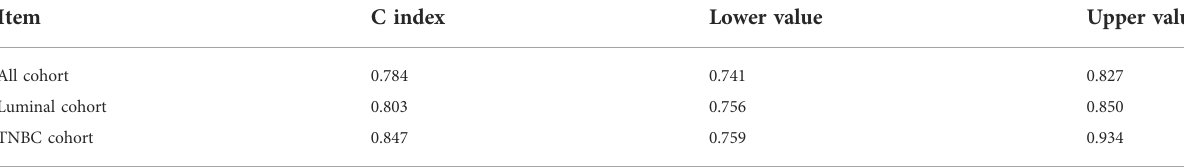
TABLE 3 | C-index of nomograms. The C-index value of nomograms was 0.784 [0.741 – 0.827] in all cohorts, 0.803 [0.756 – 0.850] in the luminal cohort, and 0.847 [0.759 – 0.934] in the TNBC cohort.